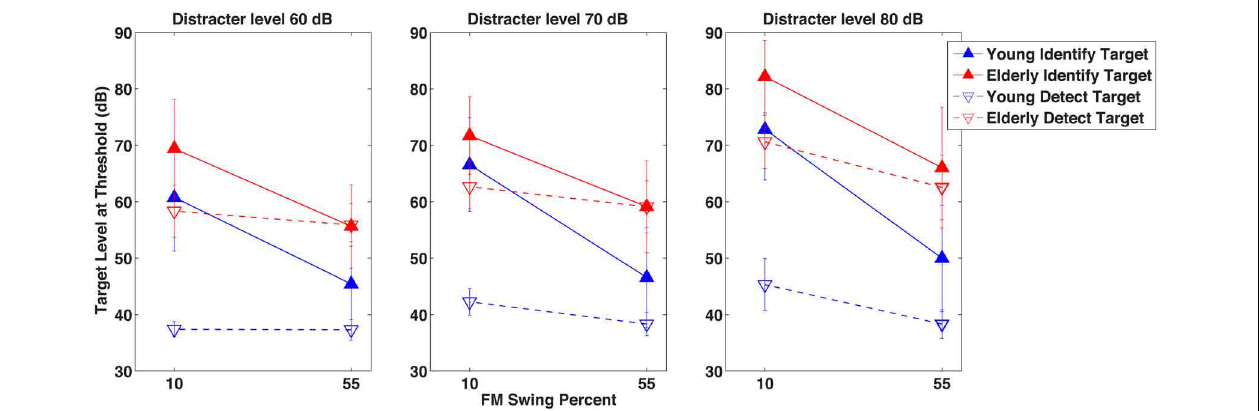
FIGURE 3 | Results of Experiment 2. A comparison of detection and identification of the target in the presence of the distracter. As in Figure 2 , target level at threshold is shown in dB as a function of the target formant’s FM excursion expressed as percent maximum displacement from 1kHz. The three separate graphs indicate data for three distracter levels in dB. Unfilled